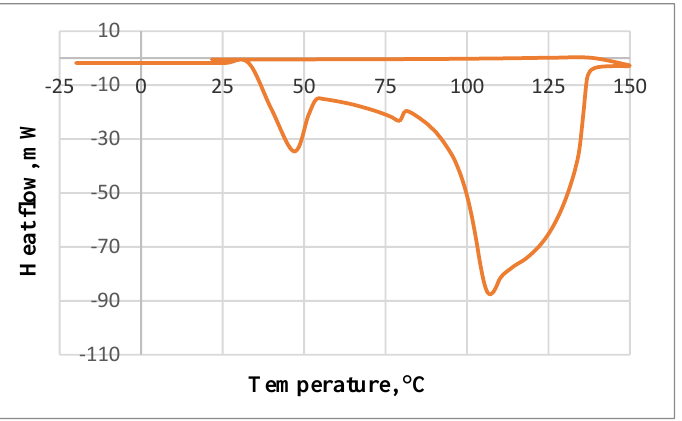
Figure 1. DSC thermogram (variation of heat flow as a function of temperature) of raw zucchini.